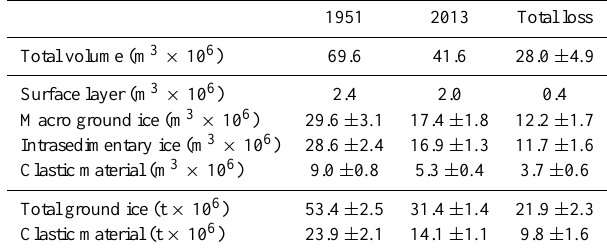
Table 2. Volumetric losses and associated mass displacement on Muostakh Island, based on DEMs of 1951 and 2013 for different compartments of the subsurface, assuming fractional volumes of 44% macro ground ice and 43% intrasedimentary ground